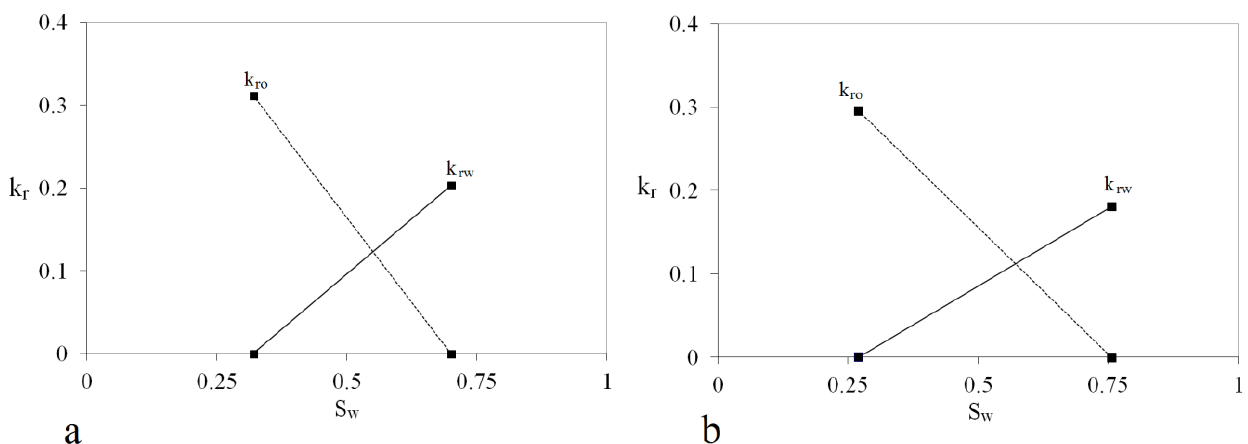
Figure 1. Relative permeability ( k ( a ) A; and ( b ) B.